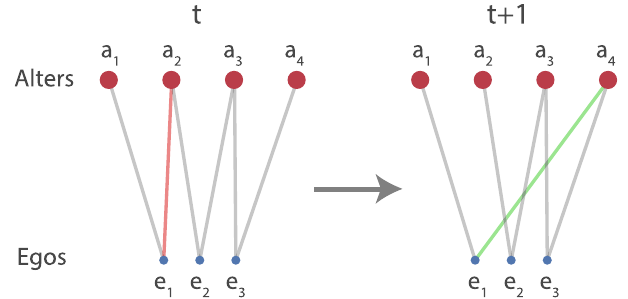
Figure 2. Intuition behind STERGMs. To capture the formation and persistence dynamics of the links, two separate models are fitted for the temporal networks of each study condition. The formation model tracks